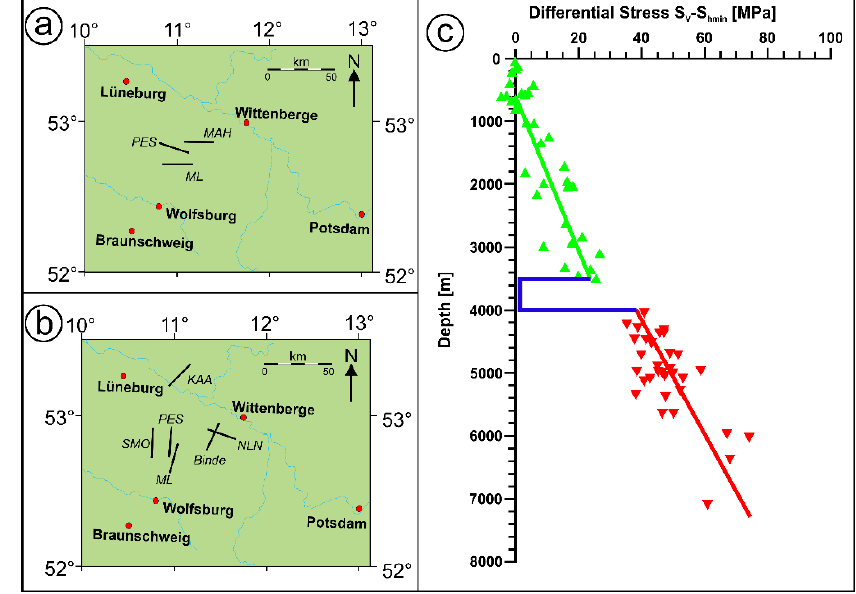
Figure 1 . Observed stress orientations and magnitudes in the North German Basin (NGB). ( a ) Orientation of the maximum horizontal Stress (S Hmax ) (black bars) above and ( b ) below the Zechstein stratigraphic unit in part of the NGB (modified after [16]). ( c ) Magnitudes of S V -S hmin -vertical stress (S V ) minus minimum horizontal stress (S hmin )—from borehole measurements in the eastern part of the NGB. The blue line corresponds to the Zechstein (salt) layer, the red triangles to the subsalt and the green triangles to the suprasalt (simplified after [12]).